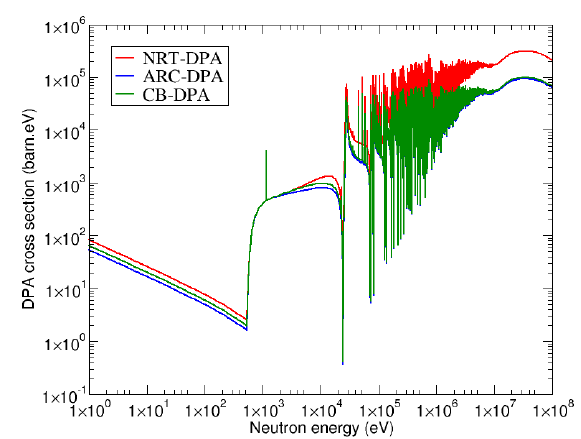
Figure 3. DPA cross sections of 56 Fe based on the JEFF-3.3 Table 2. Ratios of DPA calculated with di ff erent models to that calculated with the NRT metric for 56 Fe in the fuel cladding